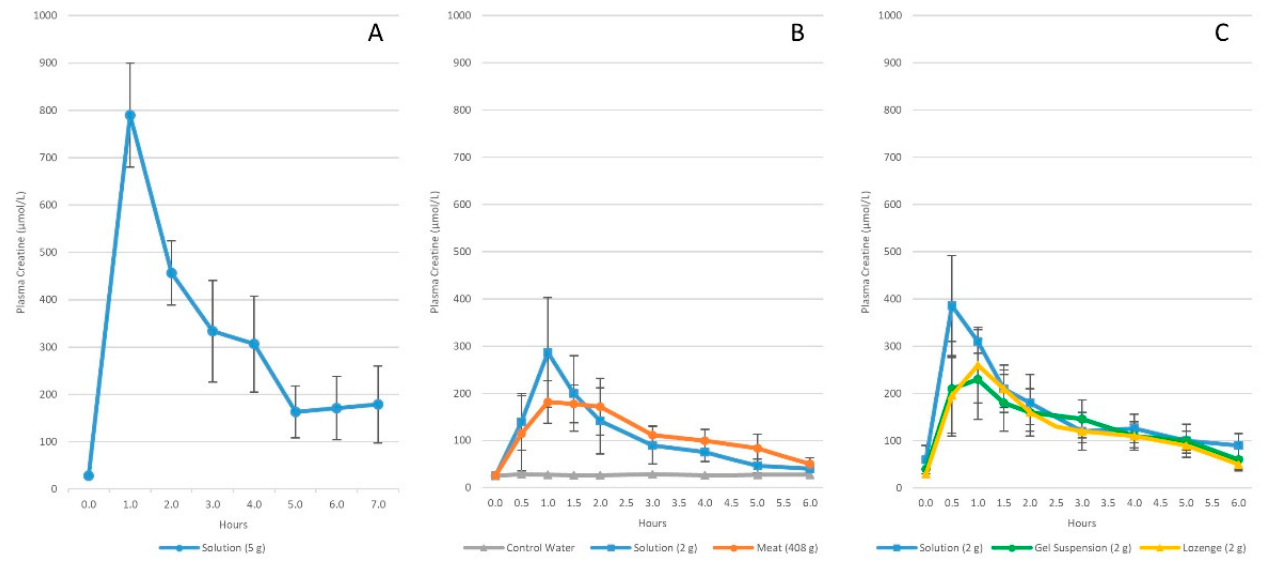
Figure 2. Changes in plasma creatine concentrations after administration of 5 g of creatine monohy- drate (CrM) in solution ( A ) [12]; water, 2 g of CrM administered in solution, or 408 g of slightly cooked meat containing 5.4 g of creatine ( B ) [45]; or 2 g of CrM provided in solution, gel suspension, or in a hard candy lozenge ( C ) [45].